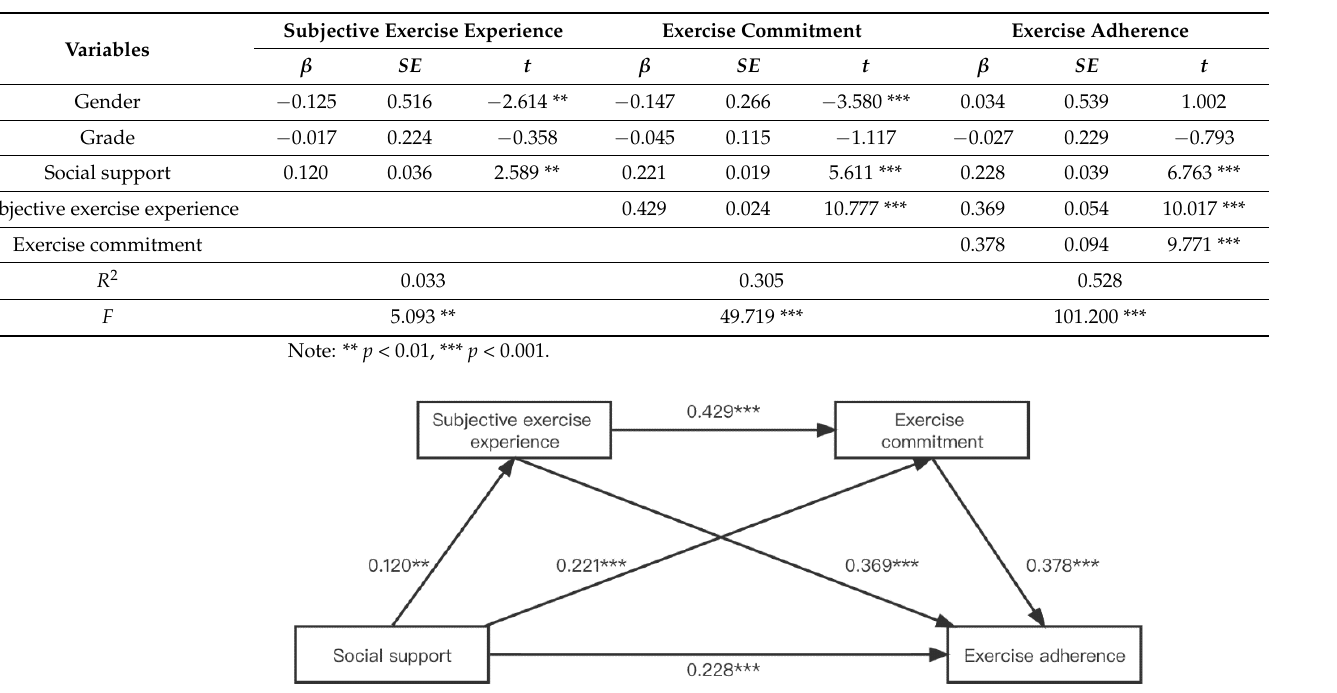
Table 3. Regression analysis of the relationship between variables in the chain mediation model.